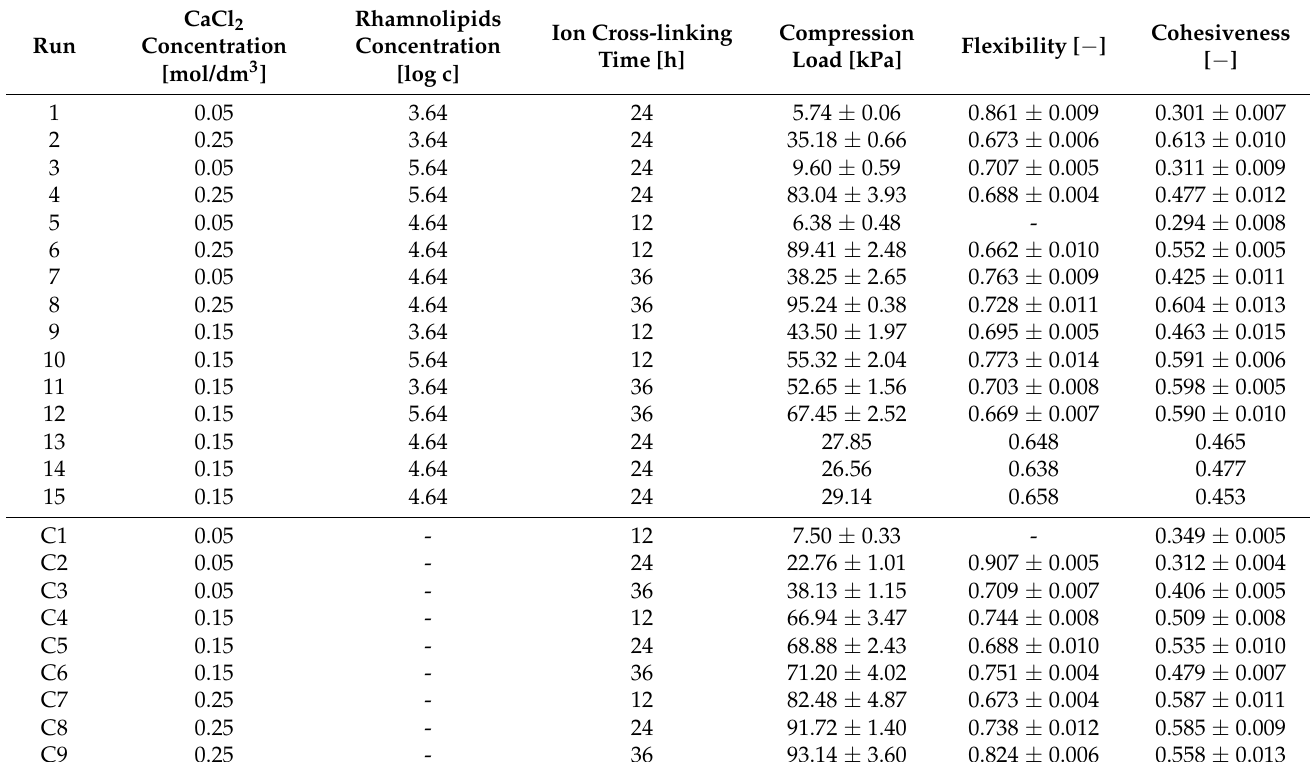
Table 3. Mechanical properties of the hydrogels prepared according to the Box-Behnken plan (samples 1–15), and hydrogels without rhamnolipids (control samples